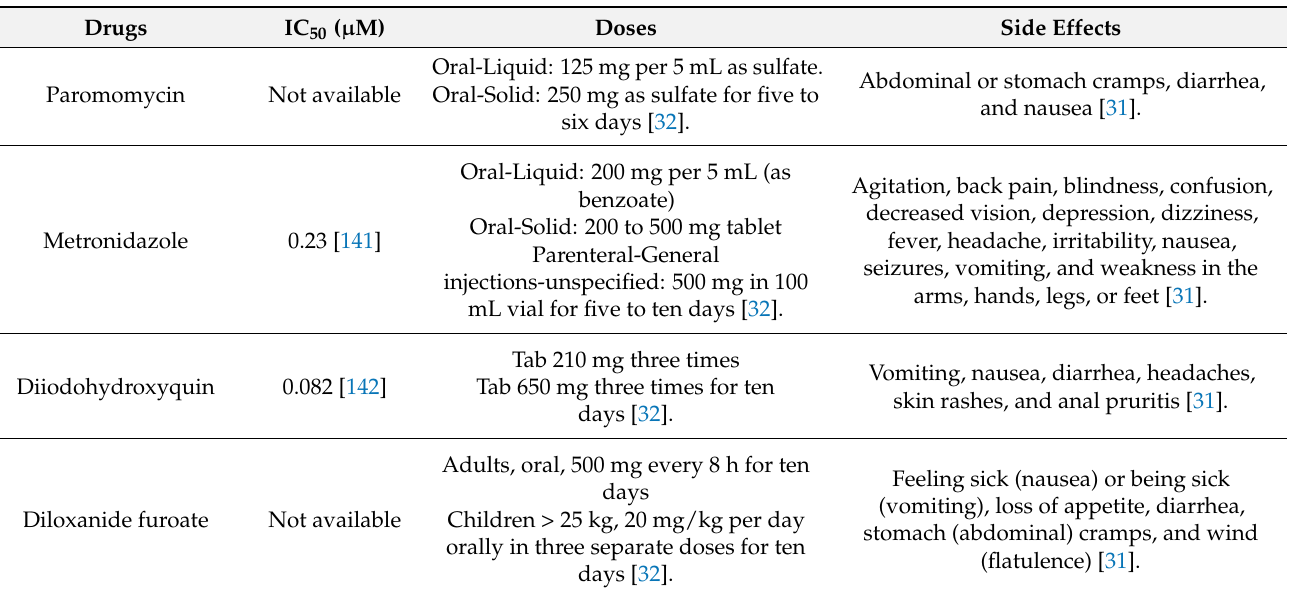
Figure 12. Main drugs used for pharmacological treatment of amoebiasis. Table 4. Biological activity, dose, and adverse effects of first- and second-line drugs against amoebiasis.